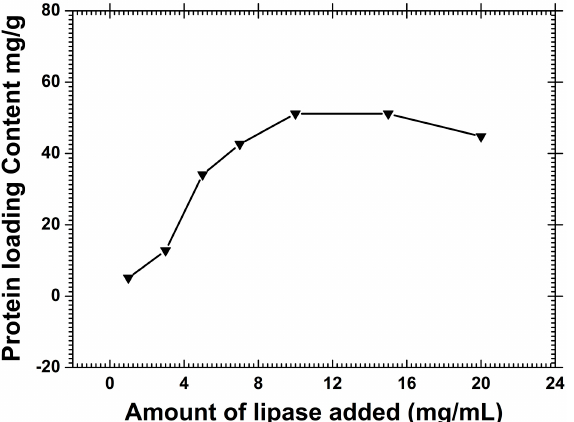
Figure 4. Effect of the amount of lipase added on protein loading content.